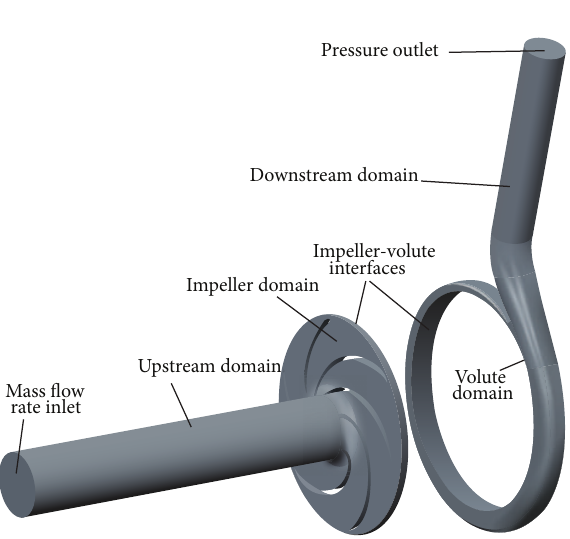
Figure 3: Flow and boundary condition